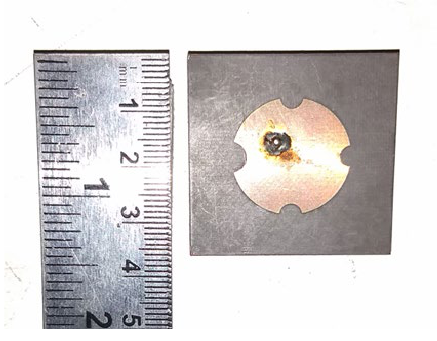
Fig. 2. The fabricated antenna.